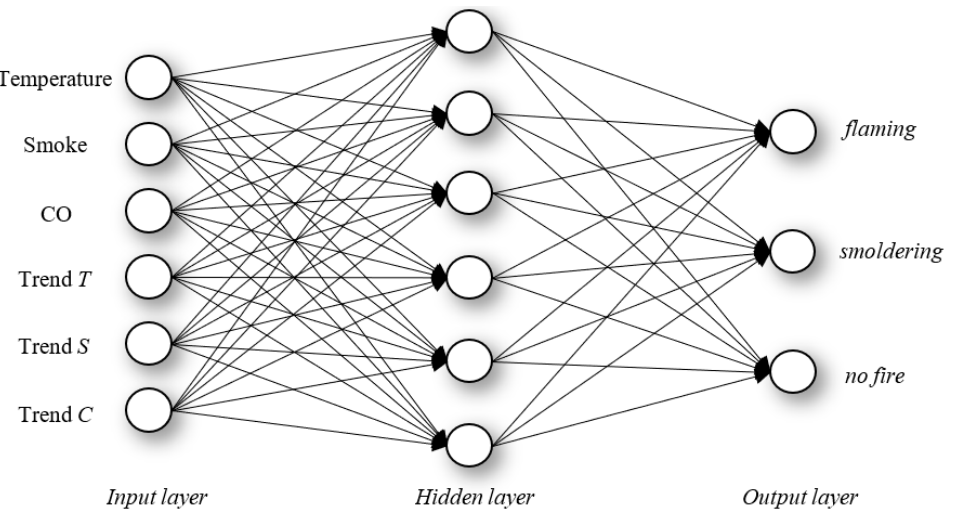
0.01 1 Transfer function between input and hidden layer. 2 Transfer function between hidden and out- put layer. 4. Results and Discussion 4.1. Training Results In terms of training parameters in Table 2, the model of the BP neural network was built and trained in MATLAB 2020a, and the performance of the BP neural network model after training is shown as Figure 5.